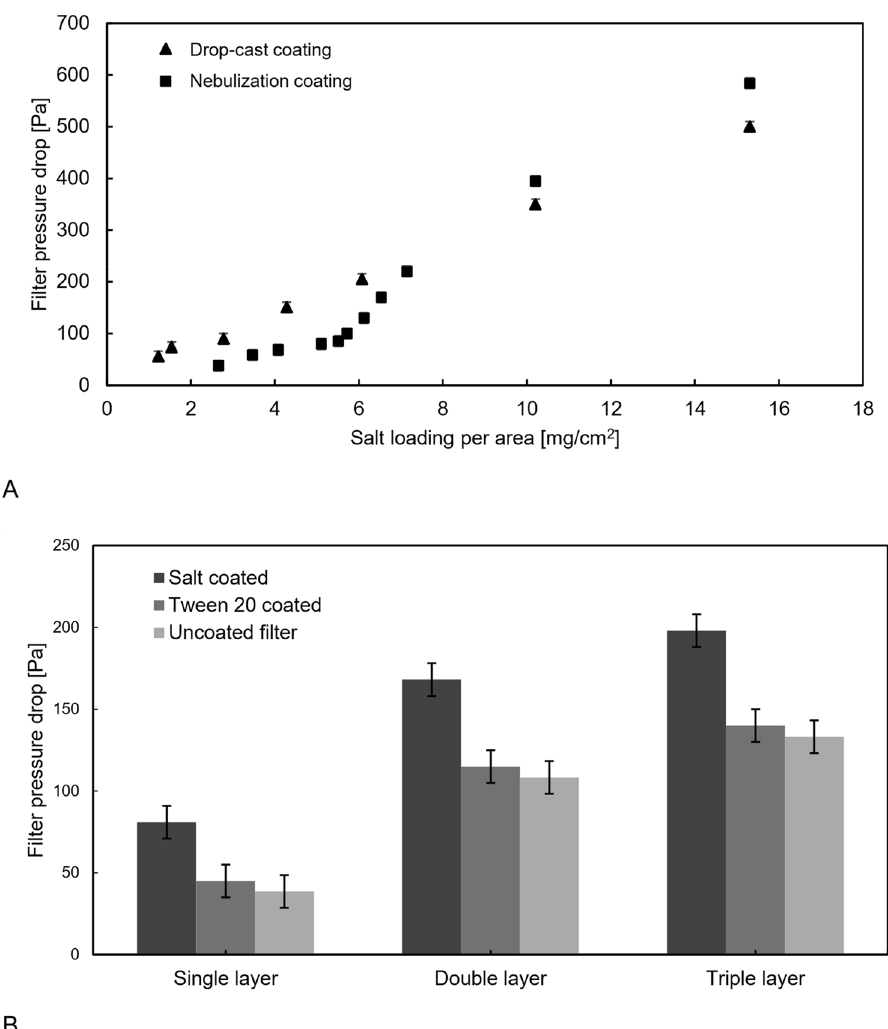
Figure 3. ( A ) Pressure drop vs. salt loading for drop-cast coating and nebulization coating; rapid increase in pressure drop after 6 mg/cm 2 of loading for nebulization coating; ( B )The effect of multilayer filters on the pressure drop for NaCl-Tween 20 and NaCl in comparison with uncoated filter. The variation in pressure drop between Tween 20 coated and uncoated filters is less than the uncertainty of the